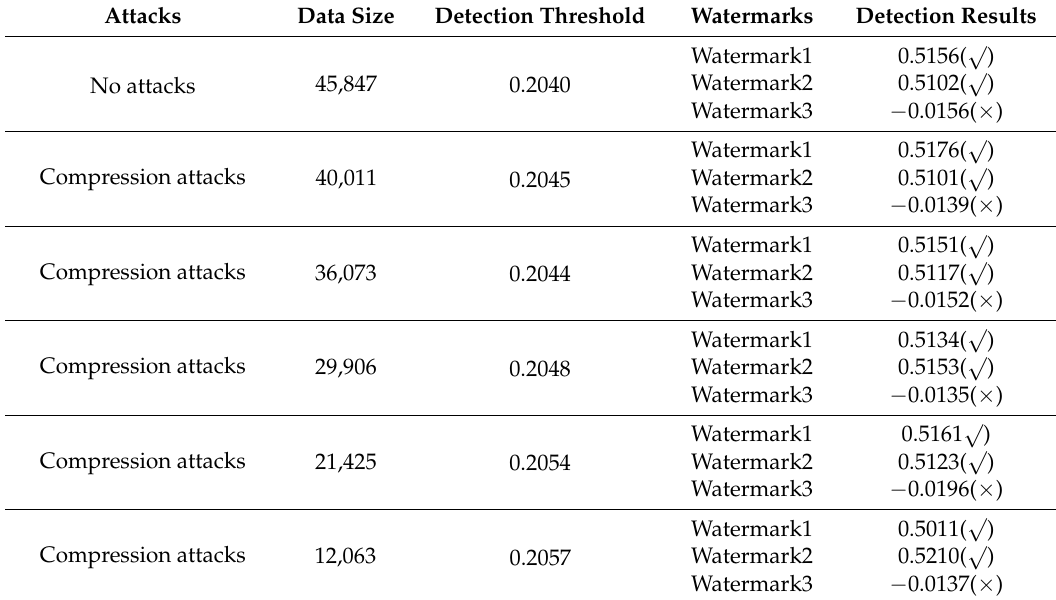
Table 3. The detection results after compression of the experimental data.